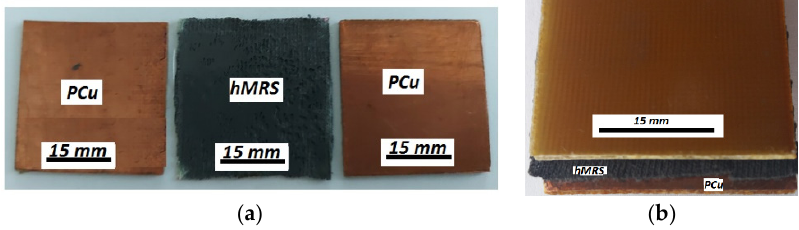
Figure 3. Manufacturing of flat capacitors (MCs): ( a ) MC components—PCu plates and hMRS sample; ( b ) assembled MC.